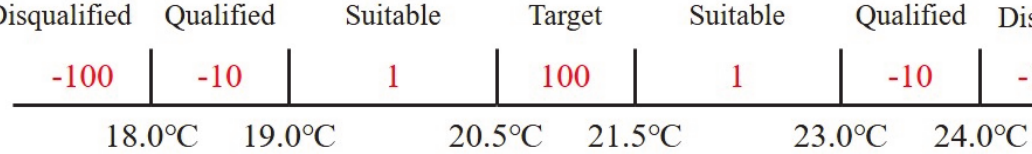
Figure 5. Design of reward function 1. Figure 6. Design of reward function 2.